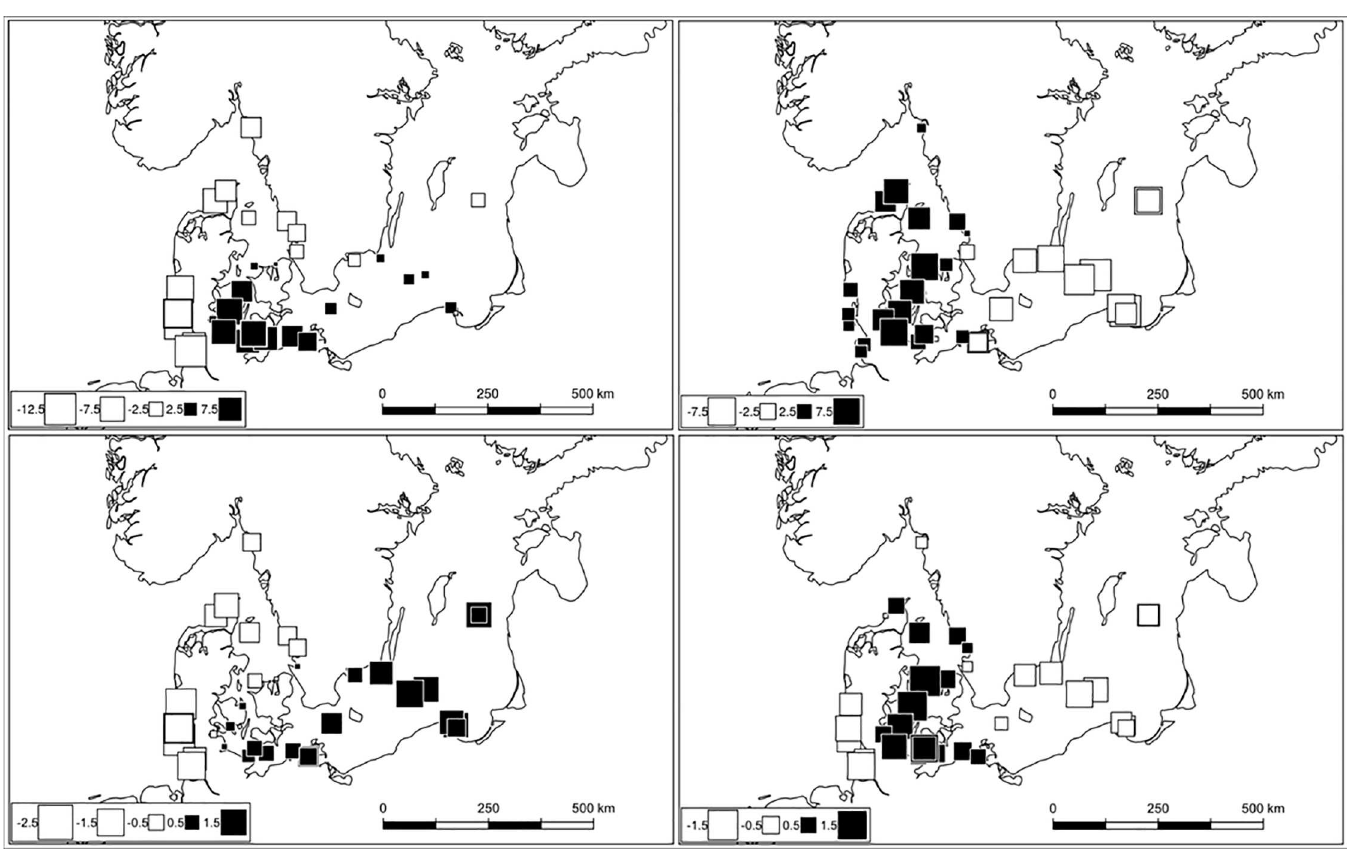
Fig 4. The first (left panels) and second (right panels) global scores of the sPCA of SNP (top panels) and microsatellite (bottom panels) datasets for the NOS to IBS subset. The squares represent the score (white–positive, black–negative) of each genotypeand are positioned accordingto their spatial coordinates on the map of the Baltic Sea and adjacent sub-regions. Map data: ESRI